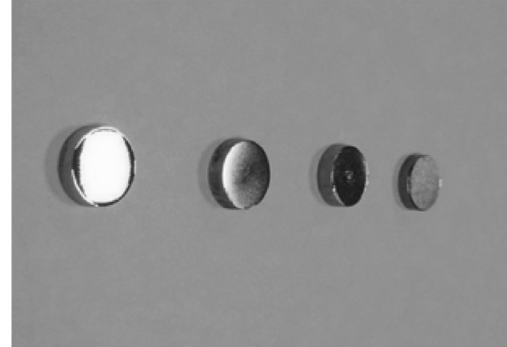
FIG. 4. Bright samples after experiments at high rotation speeds.